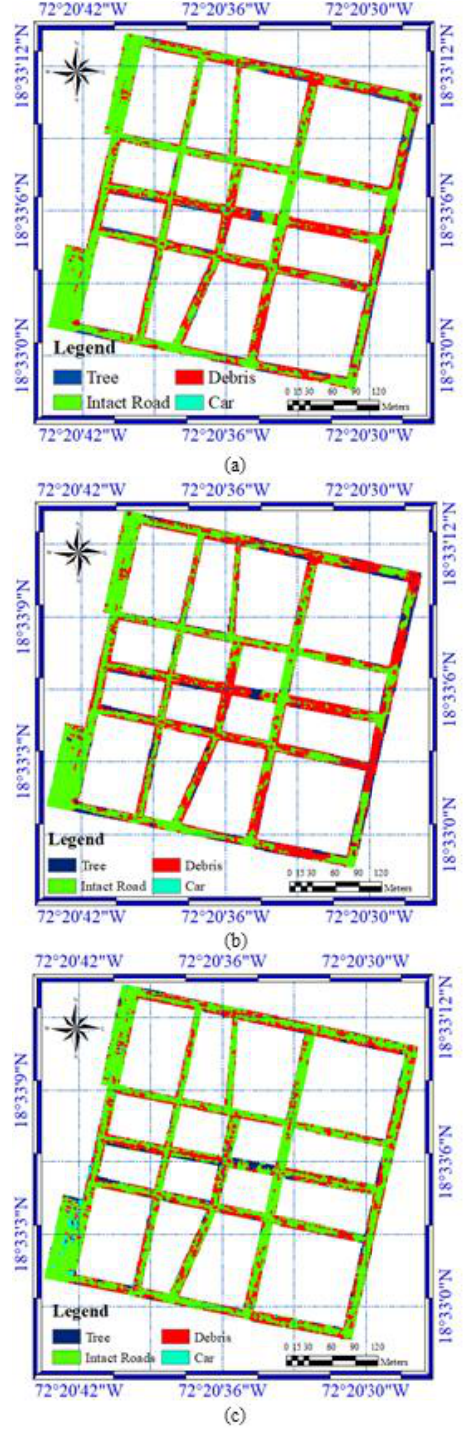
Figure 5. The result of classification on LiDAR data: (a) The MLP classifier using textural features; (b) The SVM classifier using textural features; (c) The MLP classifier applying extracted deep features by the